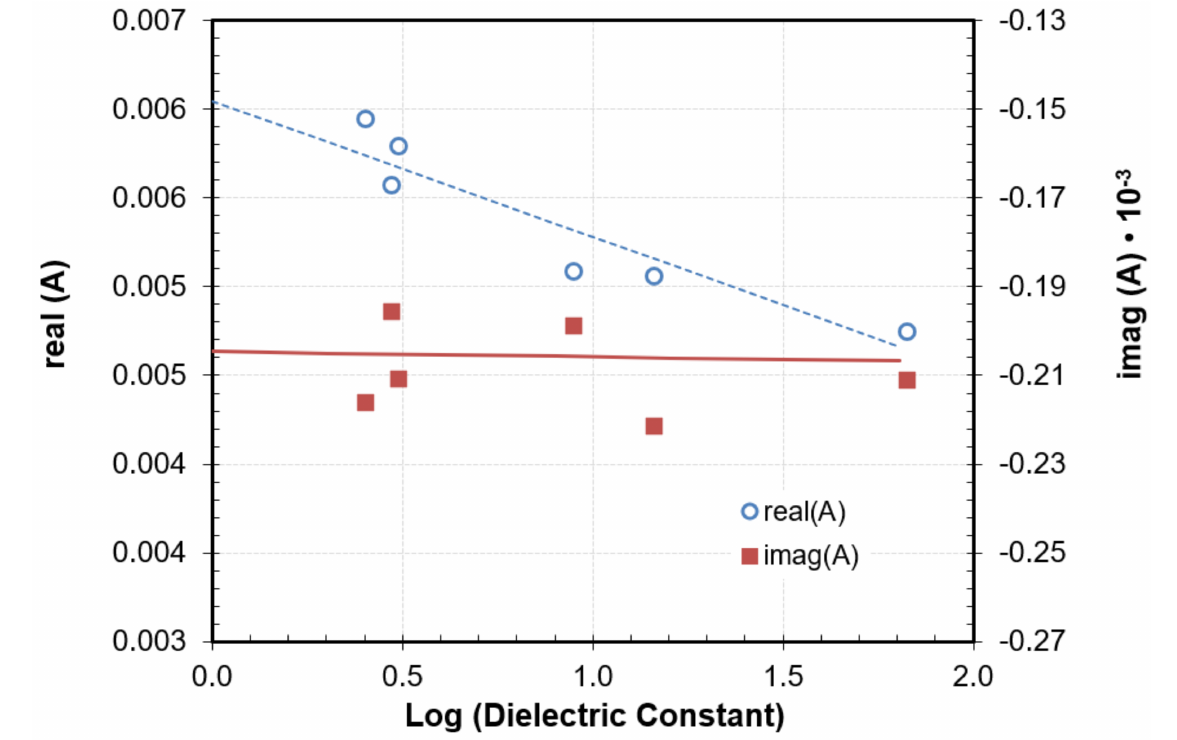
Figure 5. Calibration parameter A of the image charge model determined with reference samples as a function of the dielectric constant.